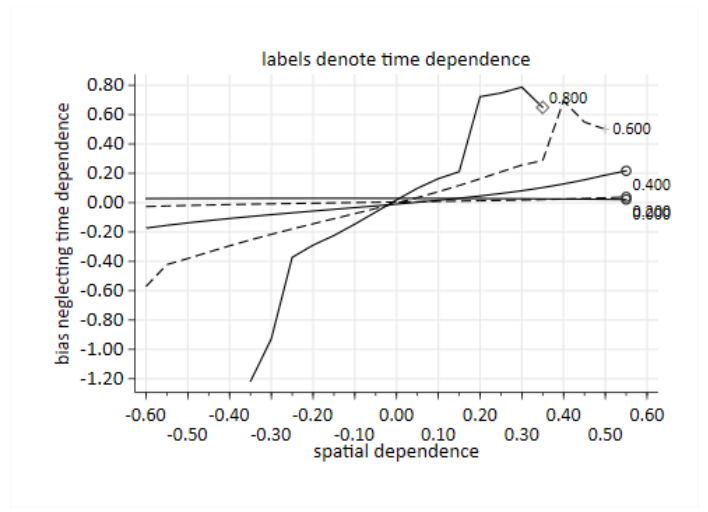
Figure E.4: Bias of Team Spatial neglecting the time dimension. The vertical axis describes λ TS − λ 0 , the horizontal axis depicts λ 0 . Labels denote spatial dependence in the DGP ( γ 0 ). Based on German NUTS 2